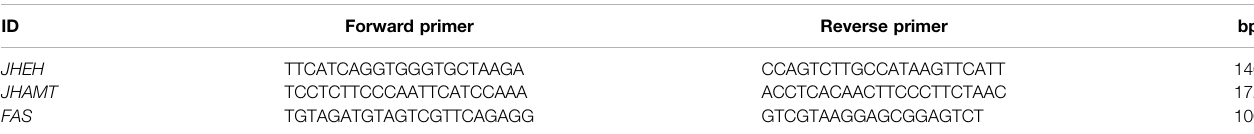
TABLE 2 | qPCR primers.